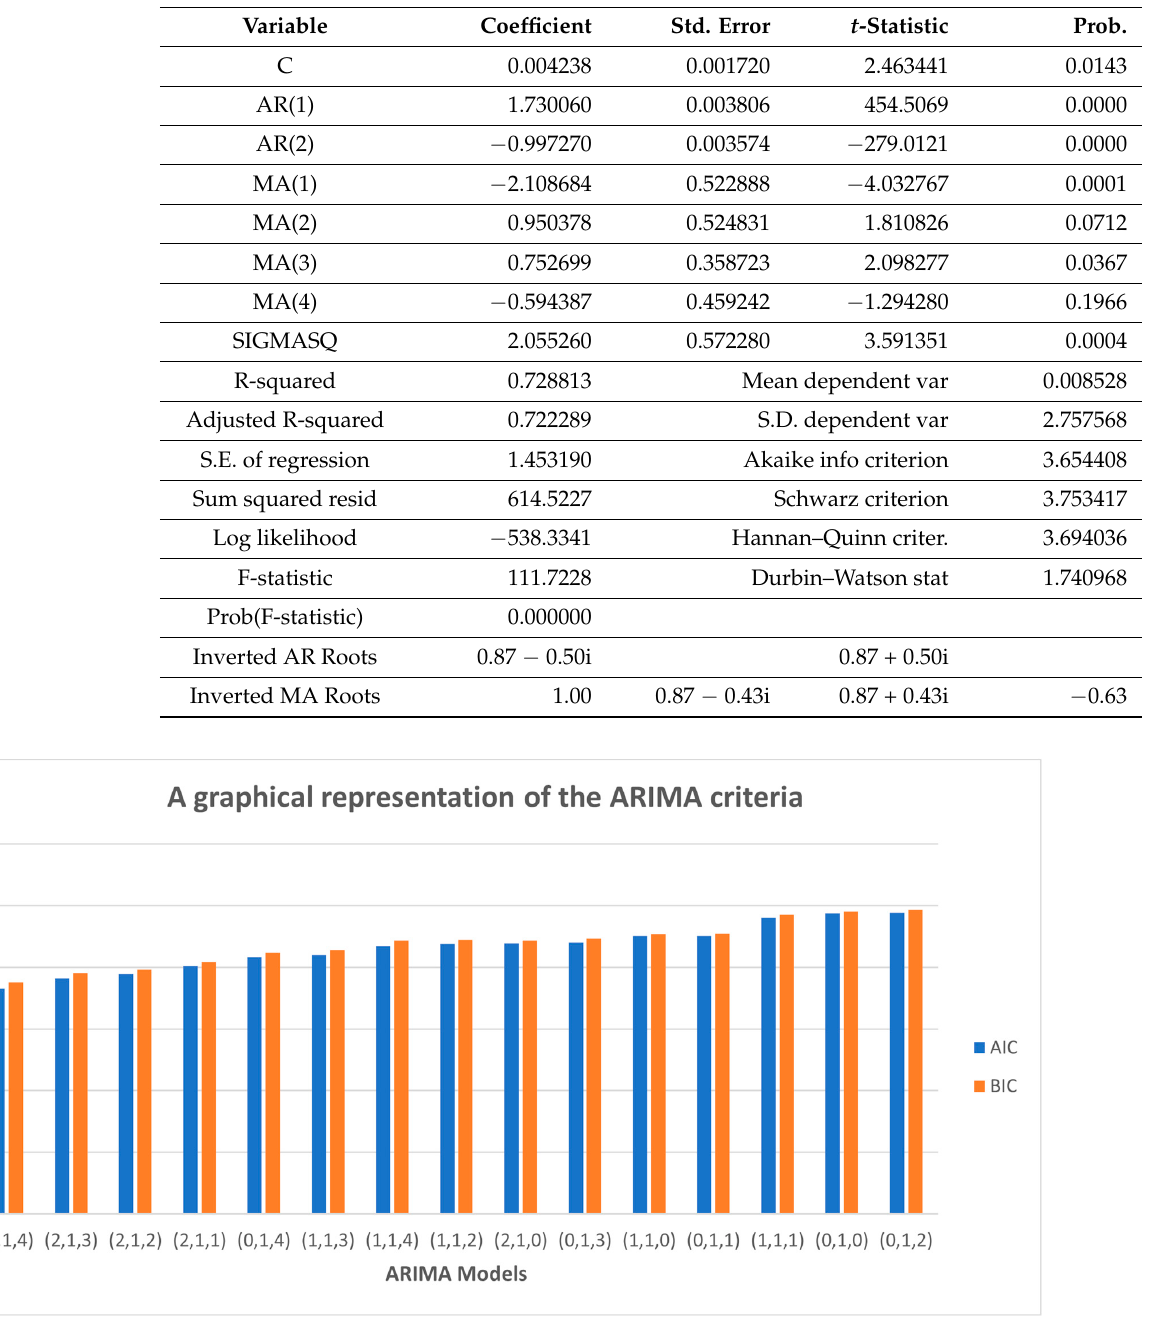
Figure 3. Graphical representation of the ARIMA criteria. Table 4. The estimated parameter of ARIMA (2, 1, 4) as the best fitted model.